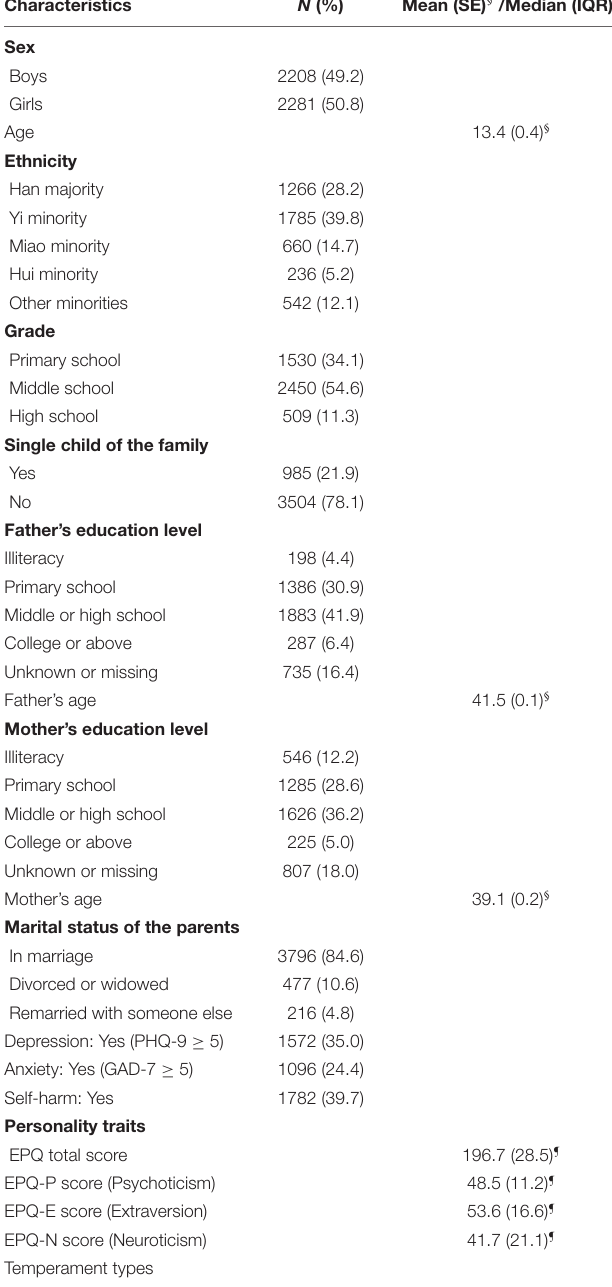
inversely associated with 1-week SI: compared with subjects of lower resilience (defined as RSCA < median), subjects of higher resilience (defined as RSCA ≥ median) were observed with a For both 1-year and lifetime SI, sex, depression, anxiety, SH, temperament types, and resilience were among the prominent covariates by the univariate model. After further adjusted by using the multivariate model, personality trait was a significant associated factor: compared with the middle type, choleric temperament and melancholic temperament were observed